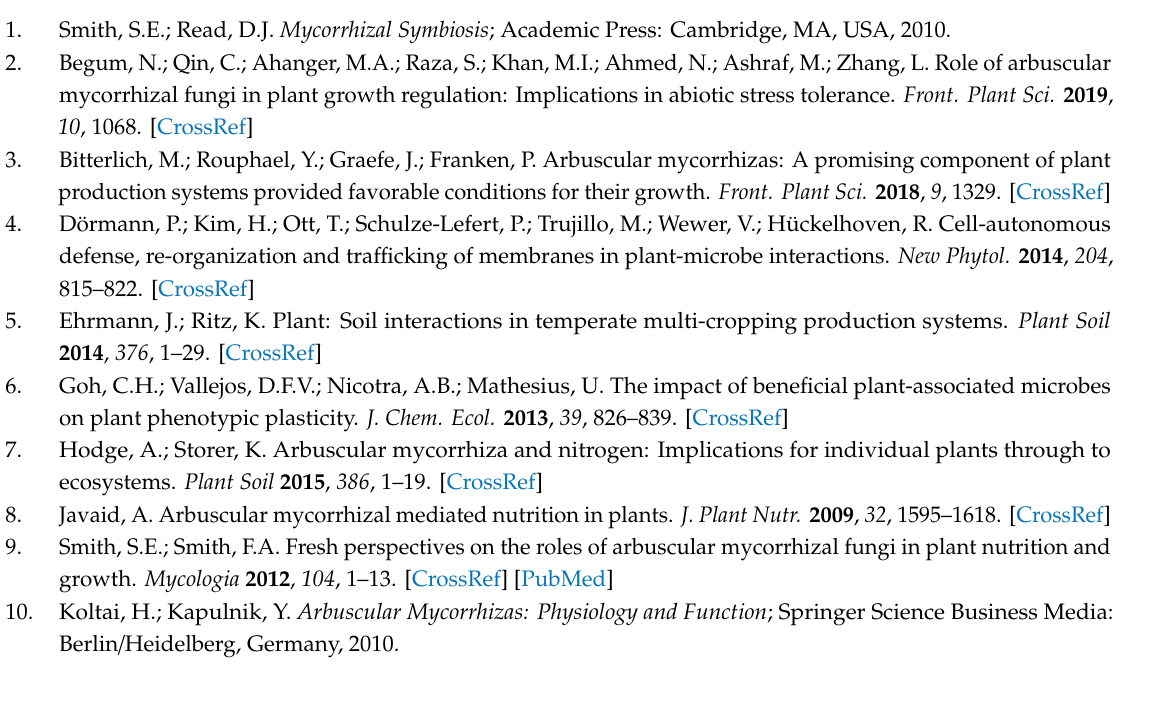
Table S1: Impact of the experimental factors on arbuscular mycorrhiza colonization in winter